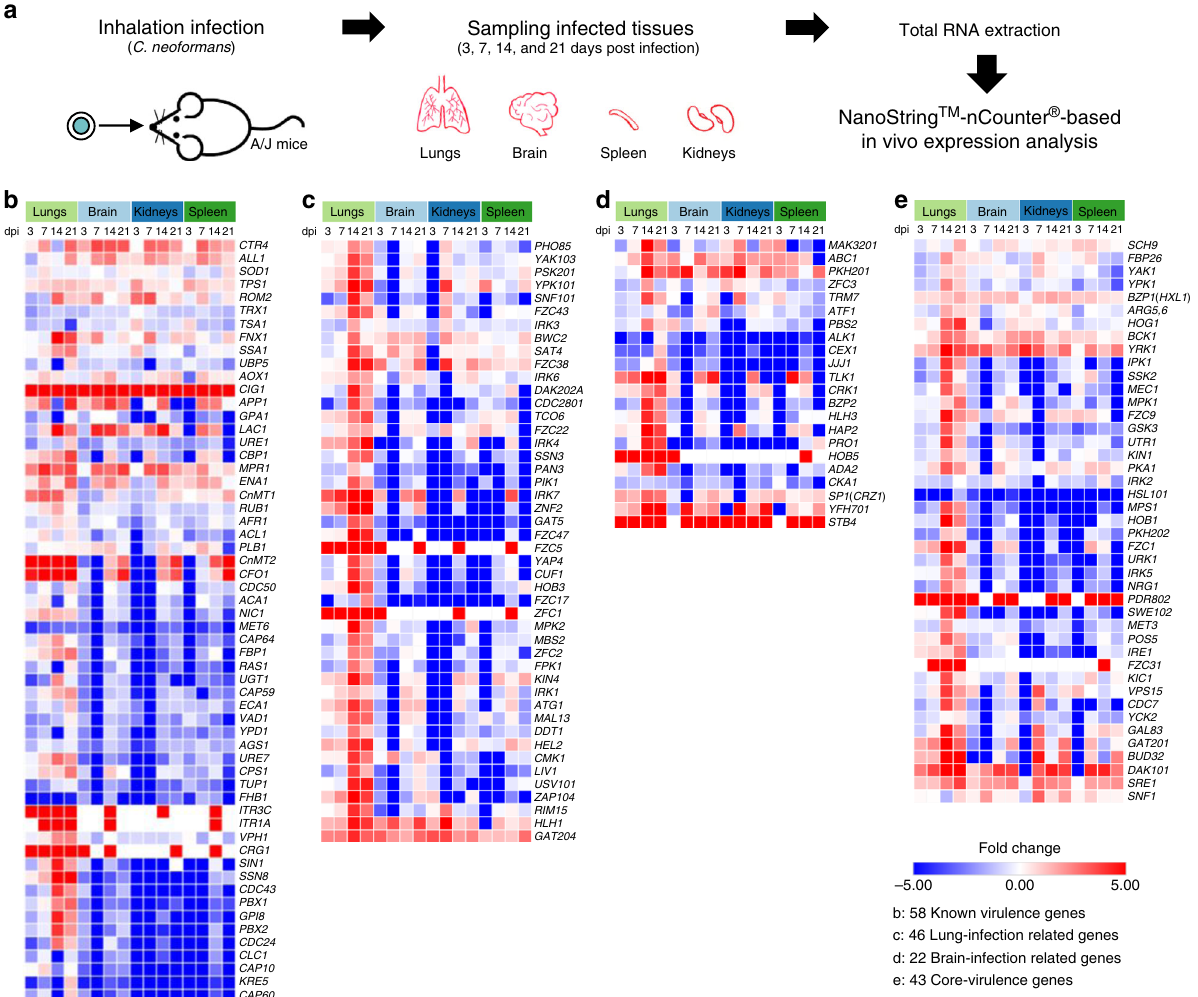
Fig. 2 In vivo expression pro fi ling of C. neoformans transcription factor and kinase genes in comparison with known cryptococcal virulence genes. ( a ) Graphical abstract of NanoString TM -nCounter ® based in vivo gene expression analysis in a murine model of systemic cryptococcosis through intranasal instillation. Total RNA was extracted from the infected lung, spleen, kidney, and brain tissues recovered after 3, 7, 14, and 21 dpi. Three mice per cohort were used (total 12 mice). Gene-speci fi c nCounter codesets were designed for 58 published virulence-related genes, 183 kinases, 180 TFs, and 8 housekeeping genes for expression normalisation (Supplementary Data 1 and Supplementary Fig. 3). ( b - e ) Fold-change heatmap of in vivo gene expression of ( b ) 58 published (known) virulence-related genes, ( c ) 42 lung-infection-related genes, ( d ) 22 brain-infection-related genes, and ( e ) 43 core- virulence